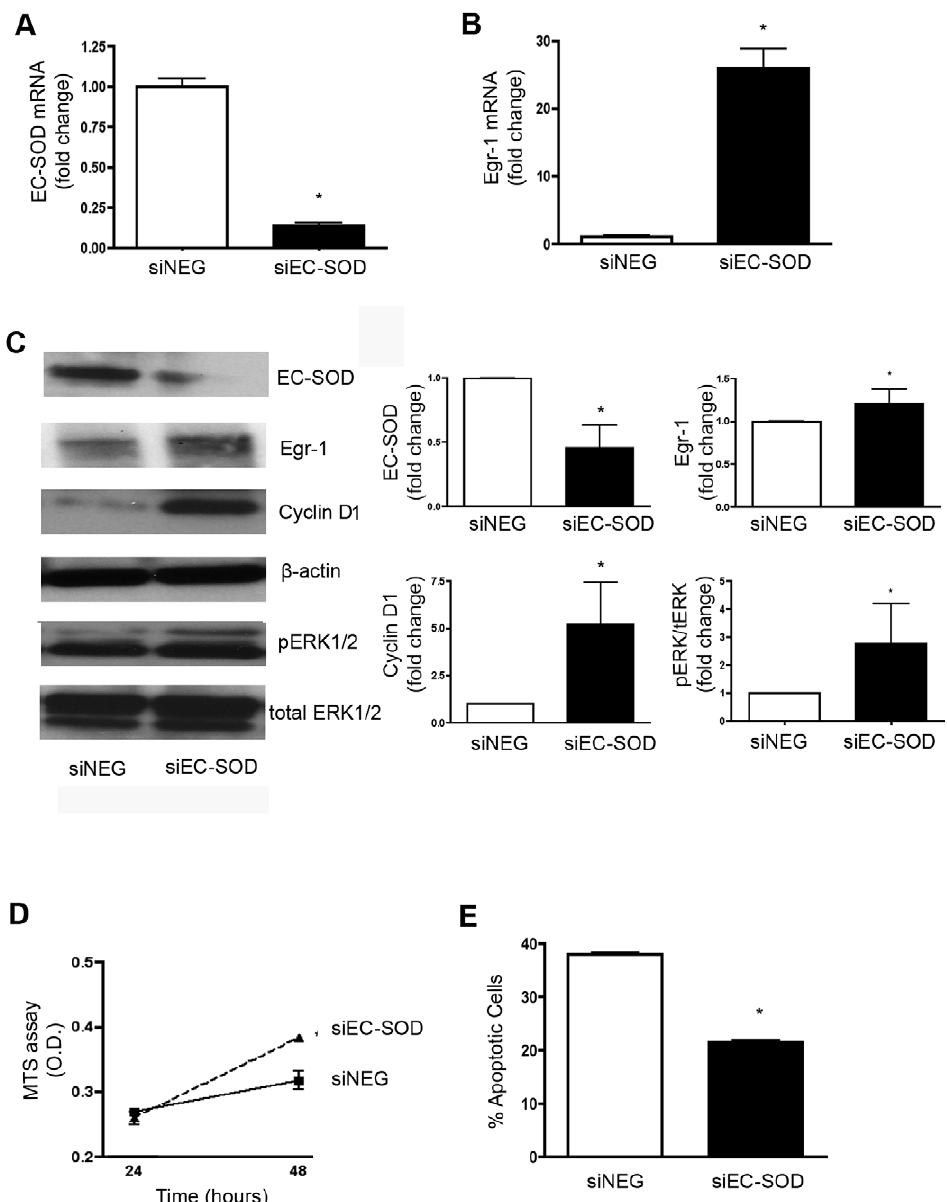
Figure 8. siRNA-mediated knock down of EC-SOD in human pulmonary artery smooth muscle cells increased Egr-1 mRNA and protein and promoted a pro-proliferative and anti-apoptotic phenotype. Human PASMC were transfected with human EC-SOD siRNA (siEC- SOD) or the negative control siRNA vector (siNEG) and experiments were performed 48 hours later. A. EC-SOD mRNA expression expressed relative to GAPDH to test the extent of knock-down of EC-SOD with siRNA. B. Fold change in Egr-1 mRNA expression expressed relative to GAPDH in human PASMC treated with siEC-SOD compared to cells treated with siNEG. Data are presented as mean 6 SEM. *p , 0.05 vs. siNEG. C. Western blot analysis in total cell lysates from human PASMC treated with siEC-SOD or siNEG. The blots were probed sequentially with the human EC-SOD antibody (1:1,000), Egr-1 antibody (1:500) cyclin D1 and ß-actin (1:1,000) to confirm equal protein loading. Blots were also probed with the phosphorylated ERK1/2 and total ERK1/2 antibodies (1:1,000). Densitometry shows fold change in EC-SOD, Egr-1 or cyclin D1 relative to ß-actin and fold change in phosphorylated relative to total ERK1/2 (n=2). D. Cell proliferation measured by MTS assay. Experiments were done in triplicate. *p , 0.05 vs. siNEG. Solid line ( & ): siNEG; dashed line ( m ): siEC-SOD *p , 0.05 vs. siNEG E . Apoptosis was assayed using the Guava Nexin kit (Guava Technologies) according to the manufacturer’s protocol. Fluorescence emission for Annexin V staining and 7-AAD was measured by flow cytometry. Experiments were done in triplicate. *p , 0.05 vs. siNEG. doi:10.1371/journal.pone.0027531.g008 finding in the cell culture experiments was that exogenous a more marked response to XO than cells isolated from normoxic generation of extracellular O 2. 2 by XO in smooth muscle cells calves. Since the SMC are a major source of vascular EC-SOD strongly upregulated Egr-1 mRNA and protein expression. and we detected less EC-SOD in the pulmonary artery of Furthermore, cells isolated from chronically hypoxic calves had chronically hypoxic calves, we speculate that the loss of EC-SOD